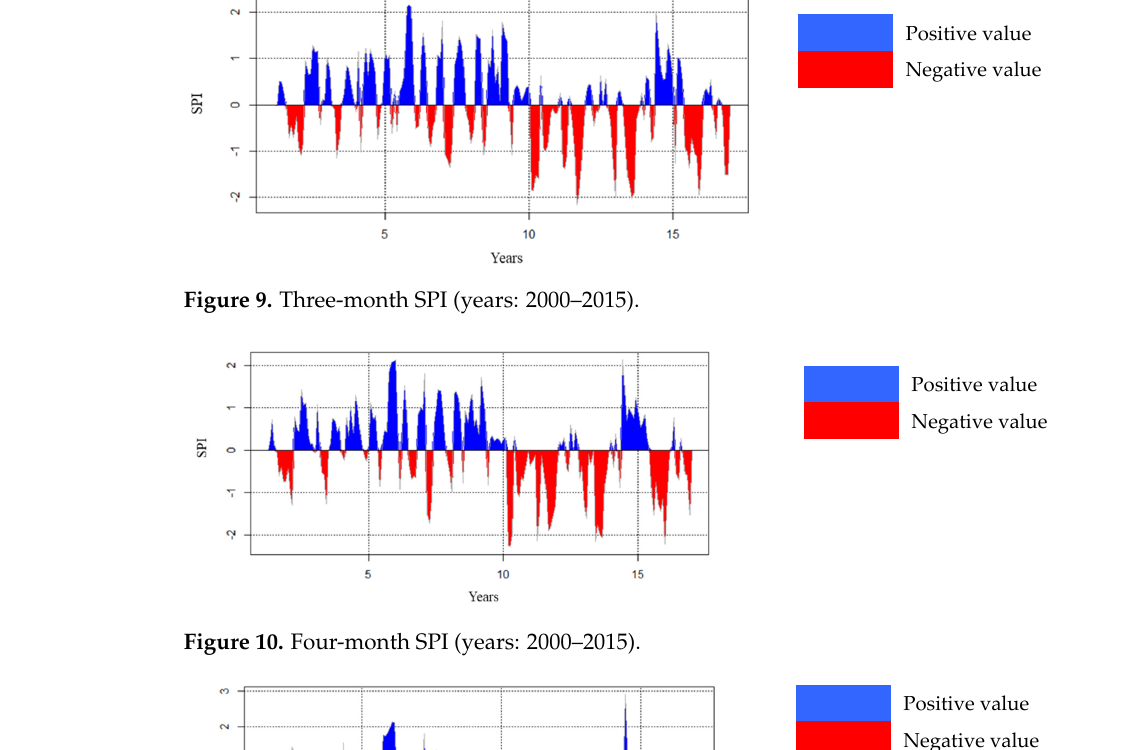
Figure 10. Four-month SPI (years: 2000–2015).